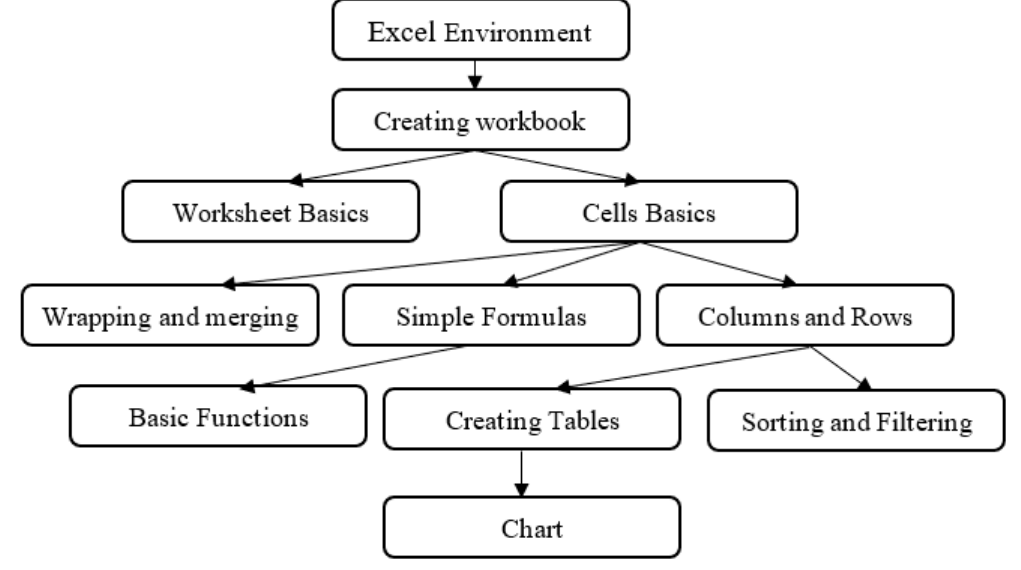
Figure 4. Bayesian network implemented in FB ‐ ITS.